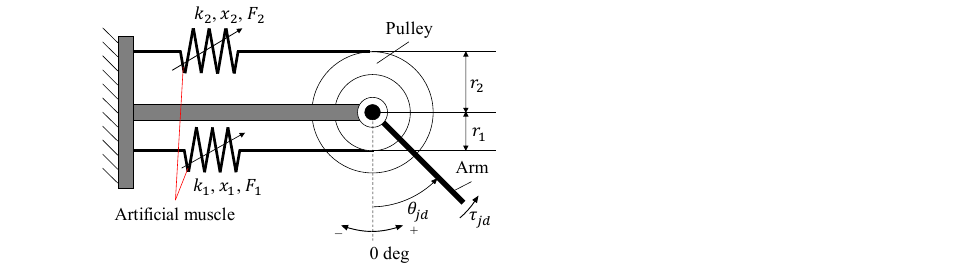
Figure 3. The model of the viscoelastic joint. This joint can obtain any joint angle and joint stiffness by controlling the air pressure applied to the artificial muscle. Table 1. Parameter of the viscoelastic joint.